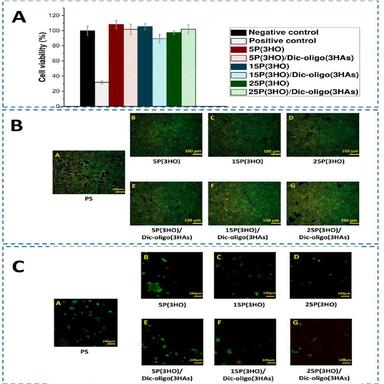
(A) The indirect cytotoxicity of the prepared materials determined in a spectrophotometric test (n = 3, N = 3); (B) The Live/Dead assay performed after indirect analysis in which cells were incubated in the presence of extracts derived from biomaterial incubation in DMEM; (C) The direct cytotoxicity assay assessed by Live/Dead staining (n = 3, N = 3).